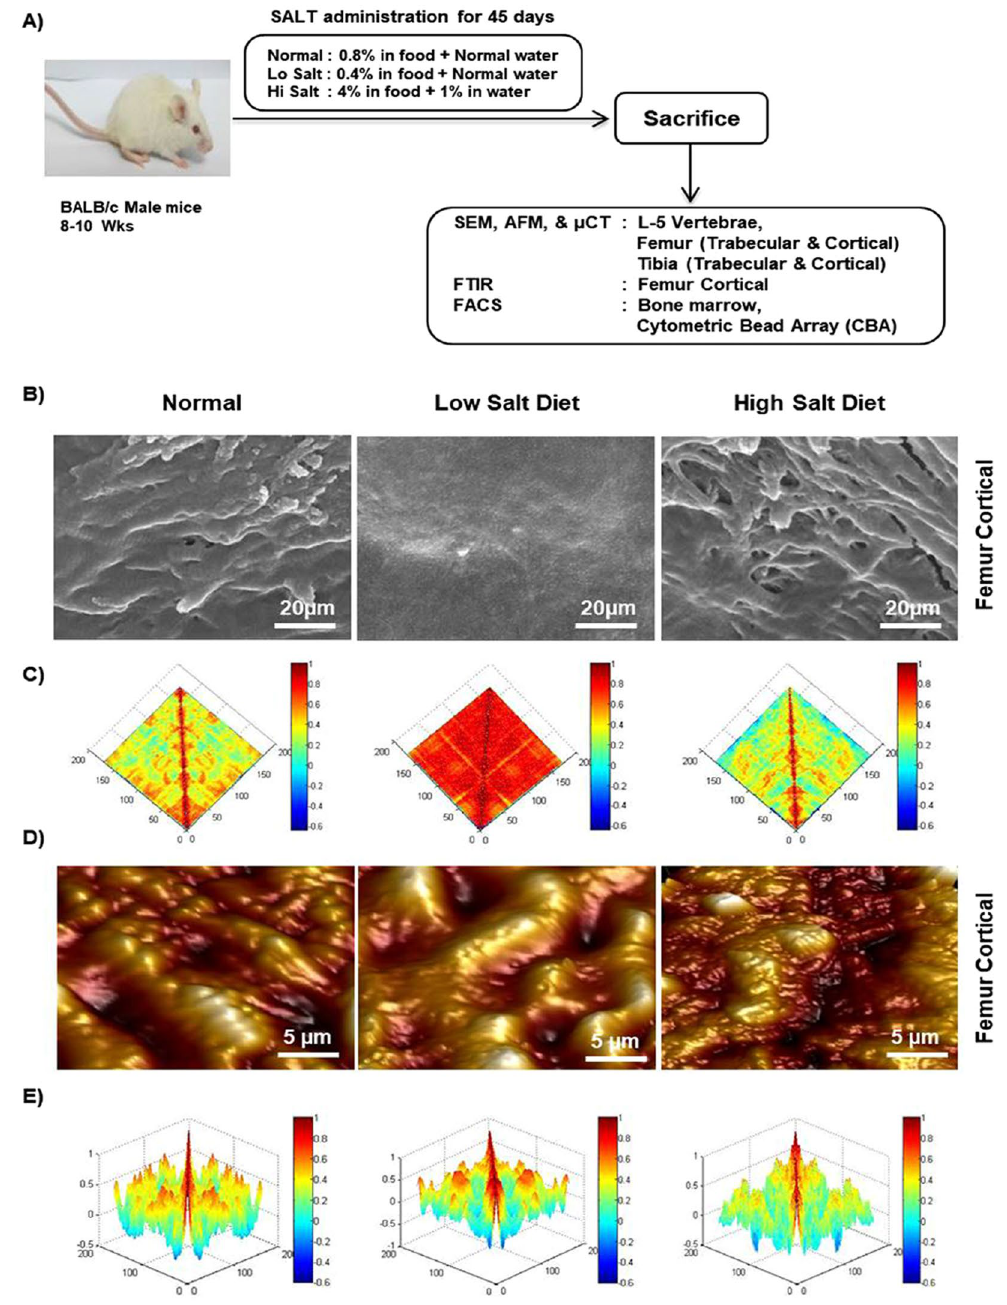
Figure 1. High dietary salt intake enhances bone loss. ( A ) Experimental work plan. Mice were divided into 3 groups. The high salt diet group (HSD) mice received diet containing 4% NaCl in chow plus 1% in drinking water. The low salt diet group (LSD) mice were fed on diet having 0.4% NaCl in chow plus normal drinking water whereas normal mice were given a diet containing 0.8% NaCl in chow plus normal drinking water for 45 days. At the end of experiment mice were sacrificed and tissues (bones + lymphoid) were analysed. ( B ) 2D SEM images of femur cortical. ( C ) 2D MATLAB analysis of SEM images. ( D ) 3D AFM images of femur cortical. ( E ) 3D MATLAB analysis of AFM images. The above images are representative of one experiment and similar results were obtained in three different experiments with n = 10 mice/group/experiment. (Mouse image courtesy: Hamid Y.